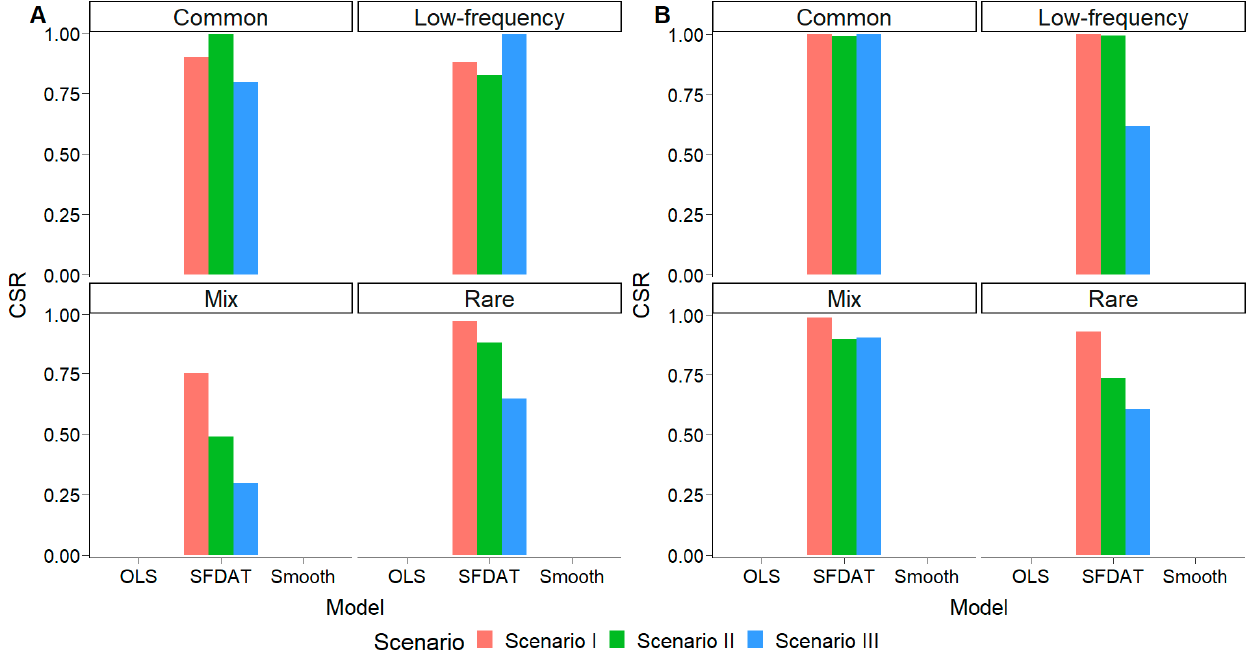
Figure 2. The simulation CSR of four variants using OLS, SFDAT and Smooth under three scenarios of Case I. ( A ): The situation of linkage equilibrium; ( B ): the situation of linkage disequilibrium; Scenario I: Set a positive causal SNP at locus 450 in the gene region. Scenario II: Set a positive causal SNP at locus 100 and 800 in the gene region, respectively. Scenario III: Set a positive causal SNP and a negative causal SNP at locus 100 and 800 in the gene region,